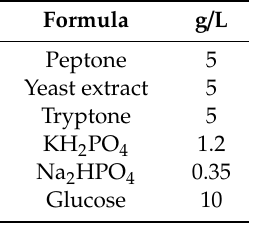
Table 3. Chemical composition of culture medium